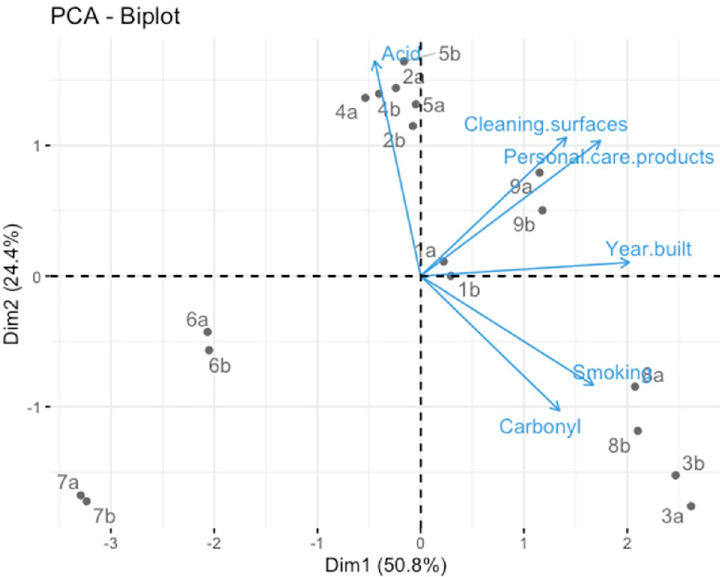
Fig 5. Biplot from PCA on sensor array responses after 48 h deployment in 9 households. The arrows show the variables (acid sensors, carbonyl sensors, cleaning, use of personal care products, smoking, year built). The length of the arrows represent the contribution of each variable to PC 1 and 2. Two sensors were deployed in each household (labelled (a) and (b)).